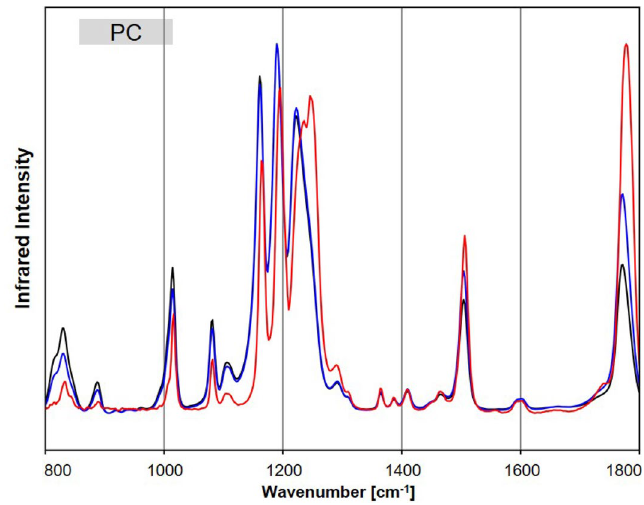
Figure 8. Exemplary spectra of PC, with the acquired raw FTIR spectrum (black), the ATR-corrected (blue) and the O-PTIR spectrum